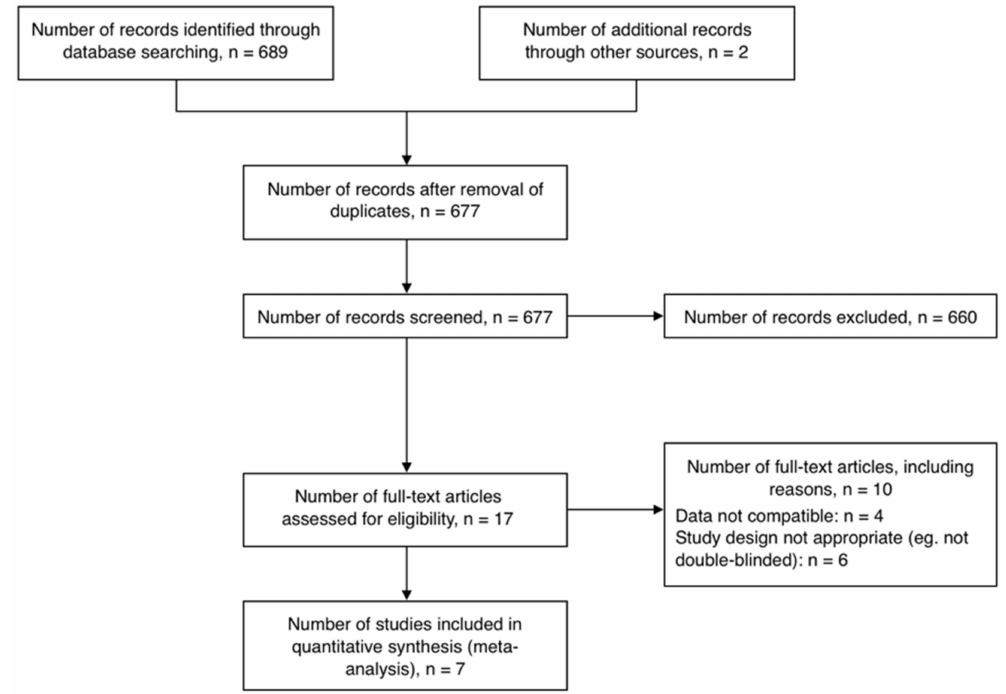
Figure 2. Flow chart for the number of studies screened, assessed for eligibility, and included in meta-analysis examining the e ff ects of SGs on human